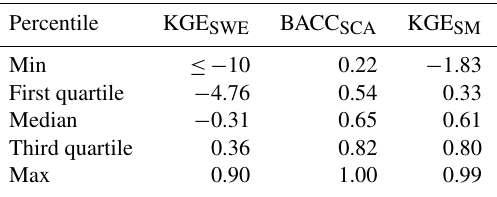
Table 6. Validation of the reconstructed snow water equivalent (SWE), snow cover area (SCA), and soil moisture (SM) in all grids at a national scale. The benchmark datasets are SD–CN for SWE, MOD10C1/MYD10C1 for SCA, and SMAP-L4 for SM. KGE: Kling–Gupta efficiency, BACC: balanced accuracy. Percentile KGE SWE BACC SCA KGE SM ≤−